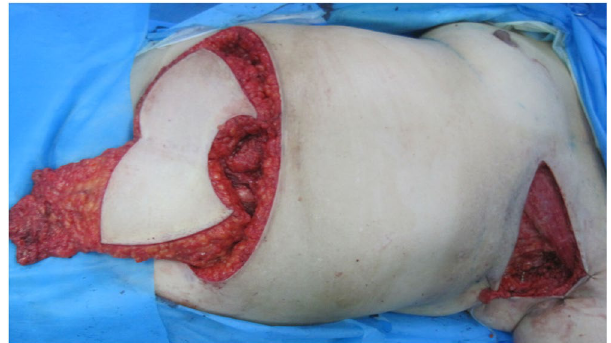
Figure 2. The lymphatic TRAM/DIEP flap. The flap for simultaneous breast reconstruction and lymph node transferring included lymphatic tissue surrounding the superficial circumflex iliac